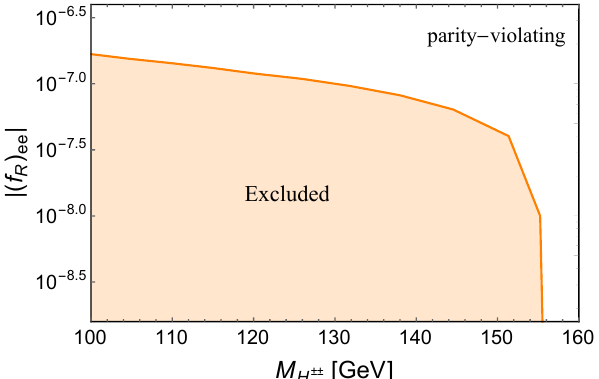
Figure 22 . Limits on M in parity-violating LRSM and the Yukawa coupling j ( f R ) ee j from H (cid:6)(cid:6) R searches of doubly-charged HSCPs by the CMS group [102]. The orange region is excluded. The p RH scale v R = 5 2 TeV and g R = g L